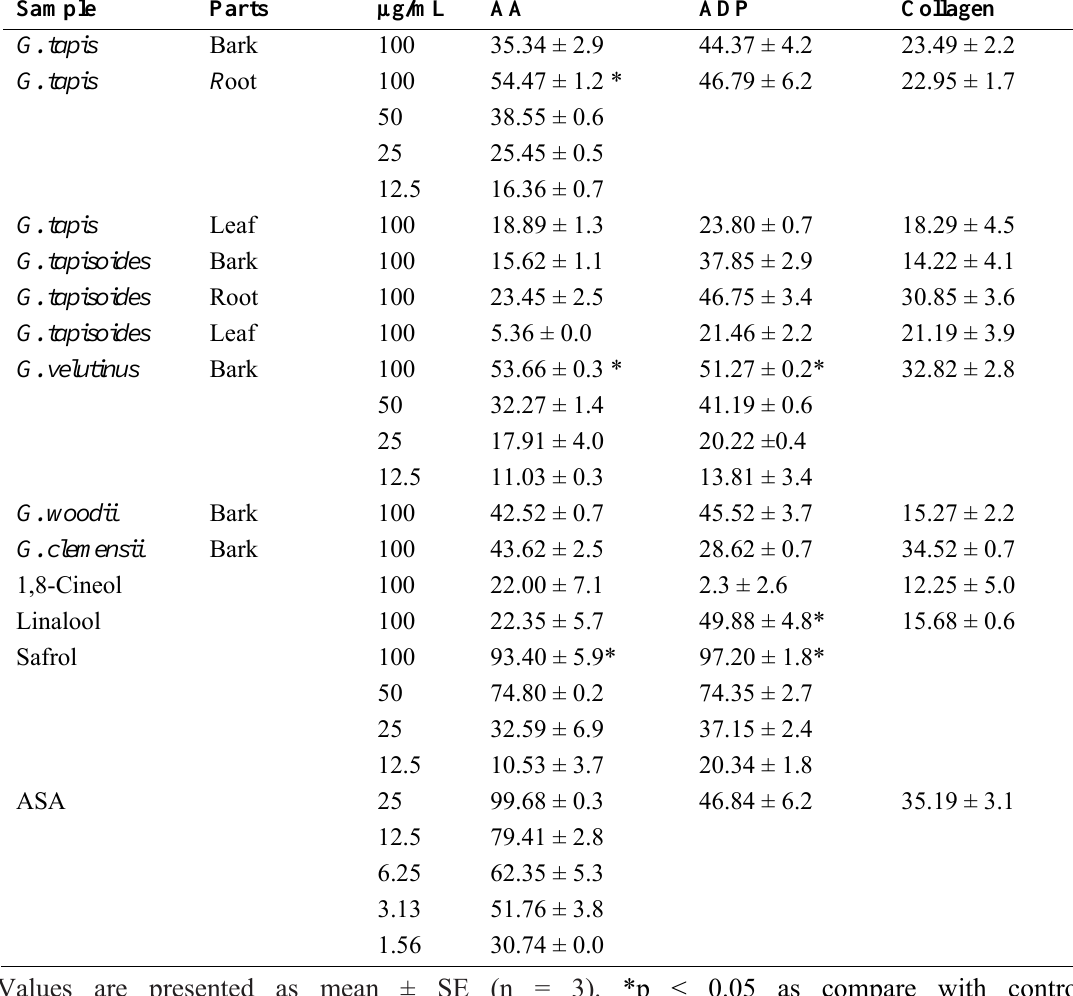
Table 3. Percentage inhibition of Goniothalamus oils and aspirin on platelet